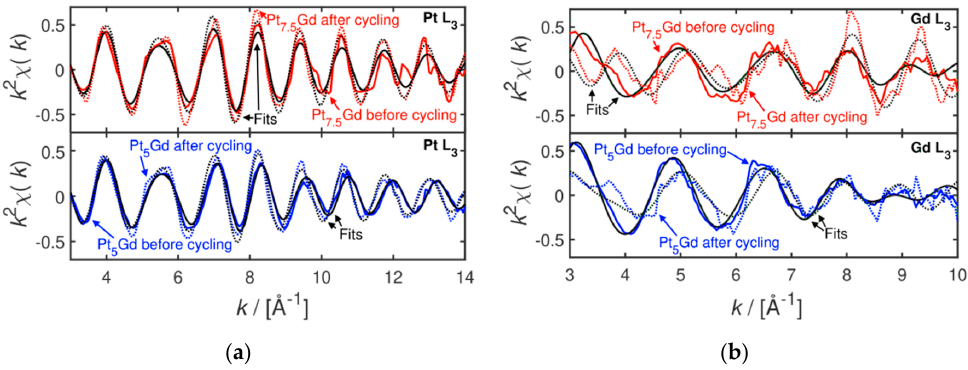
Figure 3. k 2 -weighted EXAFS oscillation function plotted vs. the wavenumber for 10-nm Pt 5 Gd and Pt 7.5 Gd thin films (blue and red, respectively) both before (full lines) and after (dashed lines) electrochemical cycling; ( a ) Pt L 3 edge; ( b ) Gd L 3 edge.